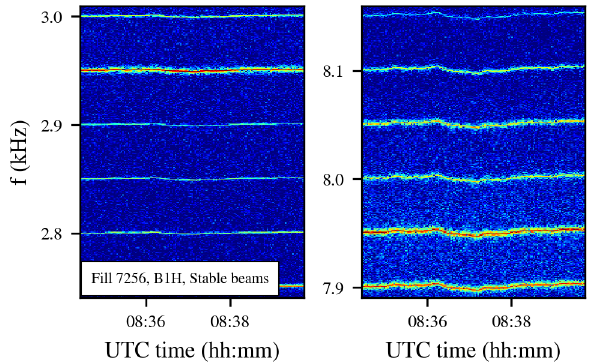
FIG. 5. The horizontal spectrogram of Beam 1 in a regime of the low (left) and high (right) frequency